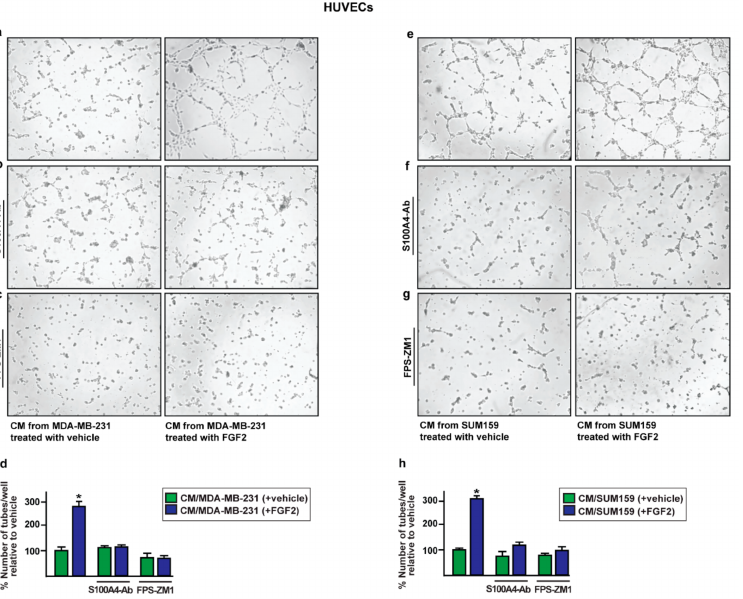
Figure 8. The paracrine activation of S100A4/RAGE signaling induces endothelial tube formation. The endothelial tube formation observed in HUVECs cultured for 6 h in conditioned medium (CM) collected from MDA-MB-231 and SUM159 cells treated for 8 h with 25 nM FGF2 ( a , e ), was no longer evident using CM collected from MDA-MB-231 and SUM159 cells which were treated for 8 h with vehicle and 25 nM FGF2 but immunodepleted for S100A4 by incubation with a mouse monoclonal antibody against S100A4 (S100A4-Ab) ( b , f ) or adding 2 µ M RAGE antagonist FPS-ZM1 ( c , g ). ( d , h ) Quantification of the number of tubes, detected in HUVECs, as indicated. Data are representative of three independent experiments performed in triplicate. (*) indicates p <